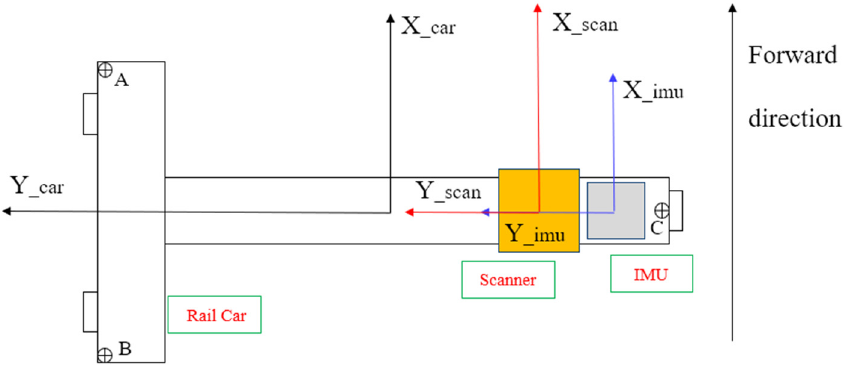
Figure 11. Relationship between the plane coordinate systems of each sensor.